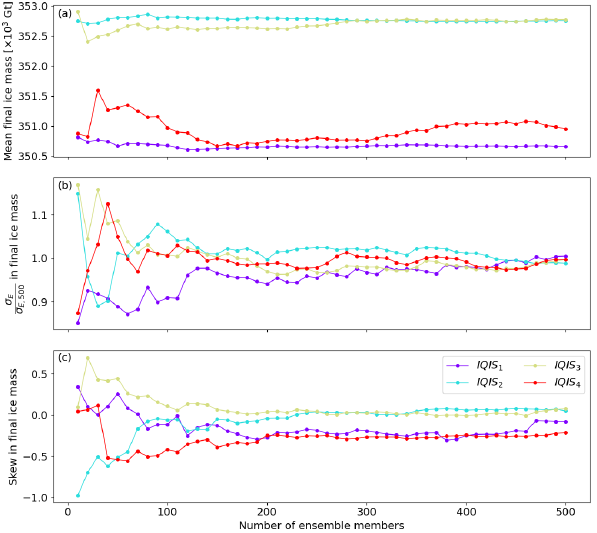
Figure C2. Convergence of the (a) mean, (b) standard deviation, and (c) skew in final ice mass for the IQIS transient ensembles as a function of number of ensemble members. For (b) , we show the standard deviation relative to the standard deviation of the full en- semble with 500 members.